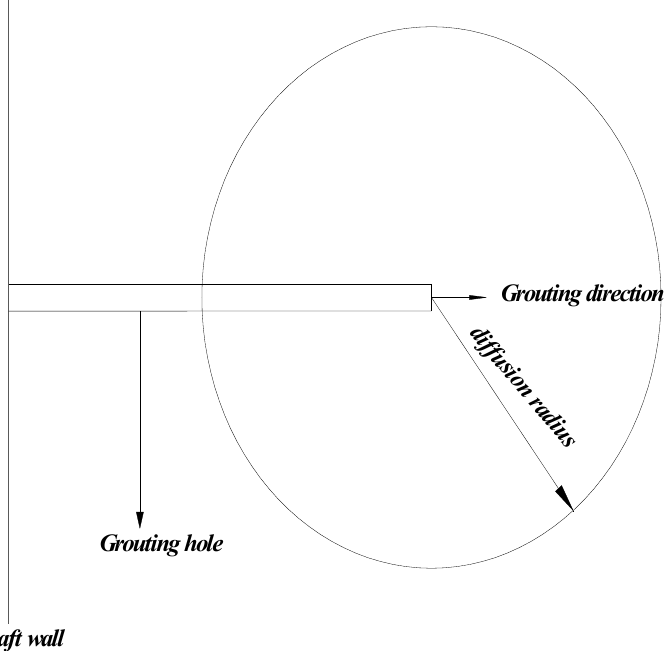
Figure 3. Single-hole grouting model behind the shaft wall.